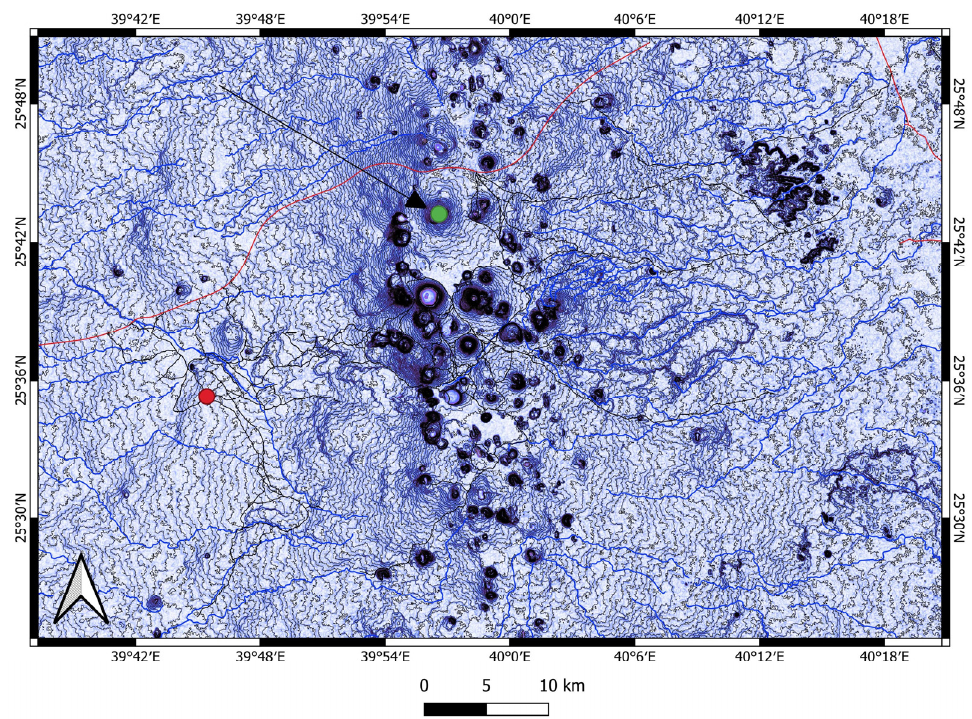
Figure 4. Slope angle map indicates a morphological step just west of the vent zones. Contour intervals are 10 m. The arrow points to Jabal Quidr (green circle). The position of Umm Jirshan Cave is marked by a red circle. The sealed road is a red line, while dirt roads are marked with black lines. Temporal stream networks are shown with blue lines.